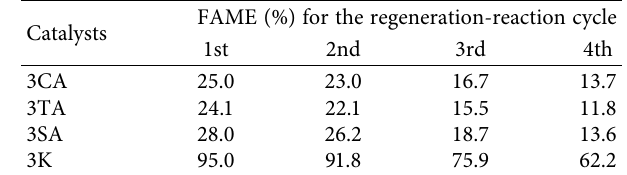
Table 5: Results of the reactivation of the best alkaline and acidic heterogeneous catalysts used in transesterification of safflower oil with methanol.